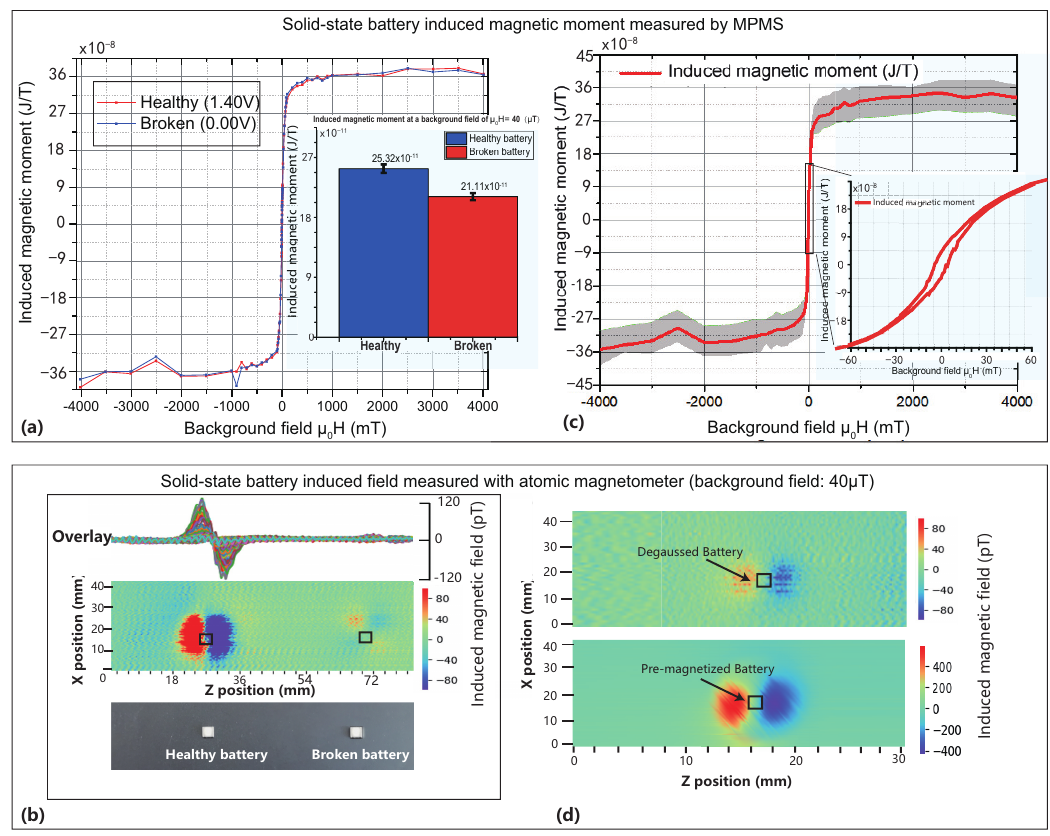
Solid-state battery induced field measured with atomic magnetometer (background field: 40μT)